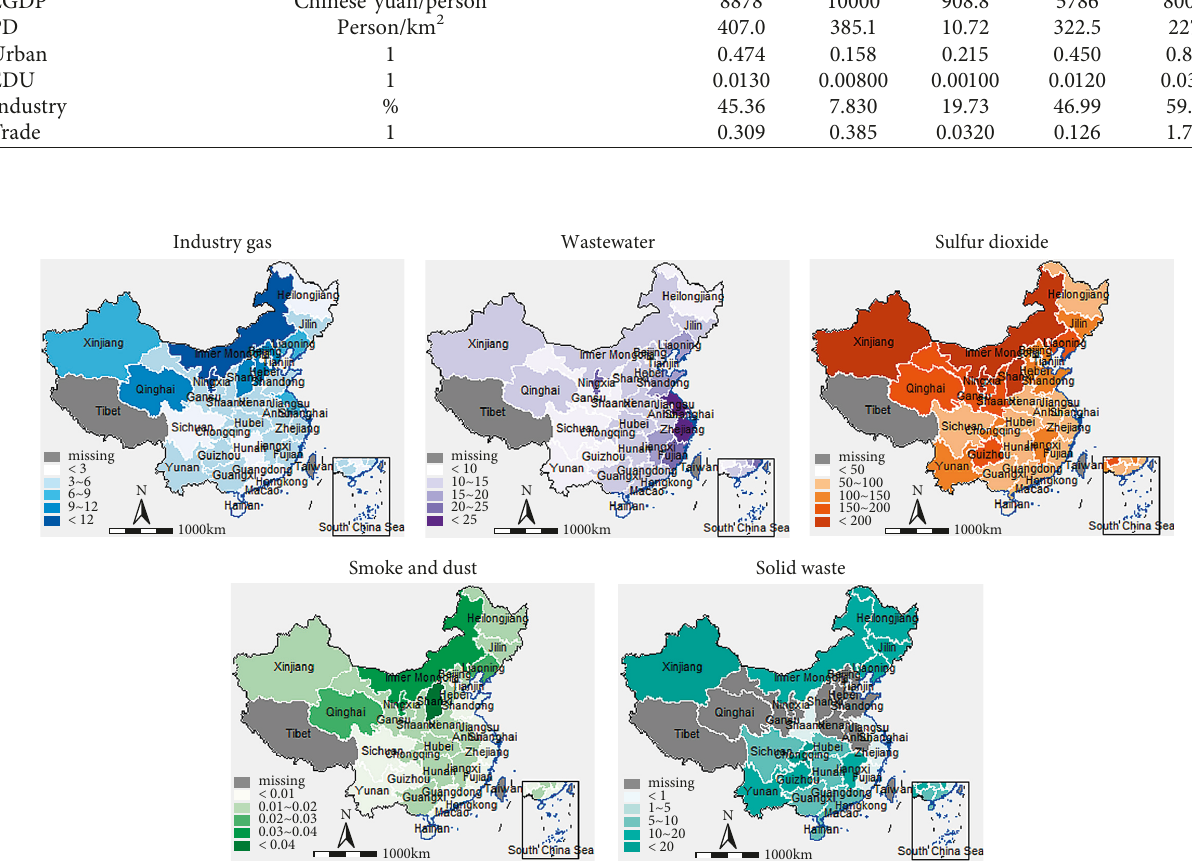
Figure 3: China’s industrial pollutant emissions in